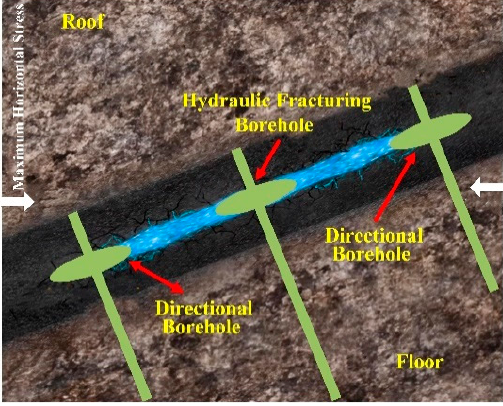
Figure 1. Directional hydraulic fracturing method.